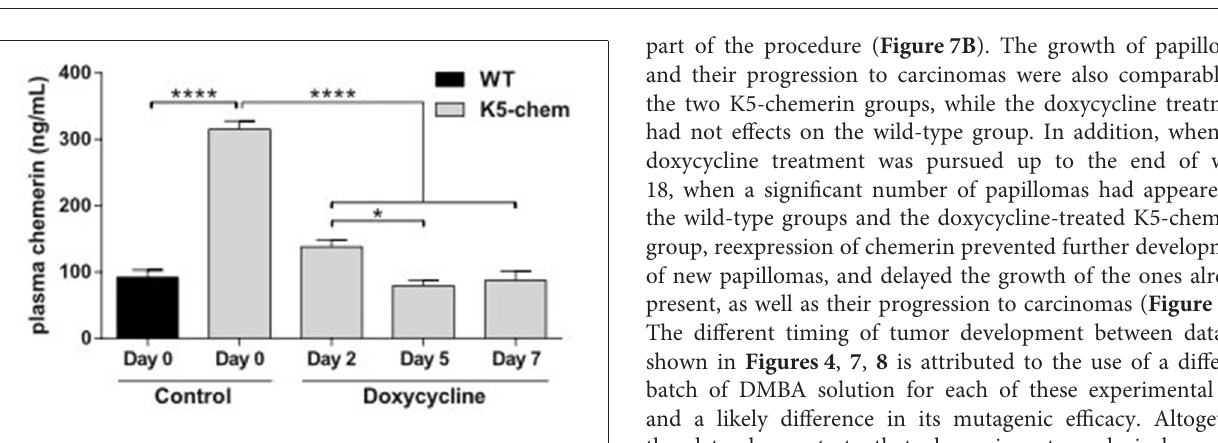
FIGURE 6 | Downregulation of the chemerin-eGFP transgene expression under doxycycline treatment. WT and K5-chemerin mice were treated with doxycycline and the chemerin immunoreactivity was measured by ELISA in plasma at 2, 5, and 7 days of treatment. The results are from a representative experiment out of two (mean ± SEM, n = 5 mice per group) and analyzed by one-way ANOVA. * P < 0.05 and **** P <